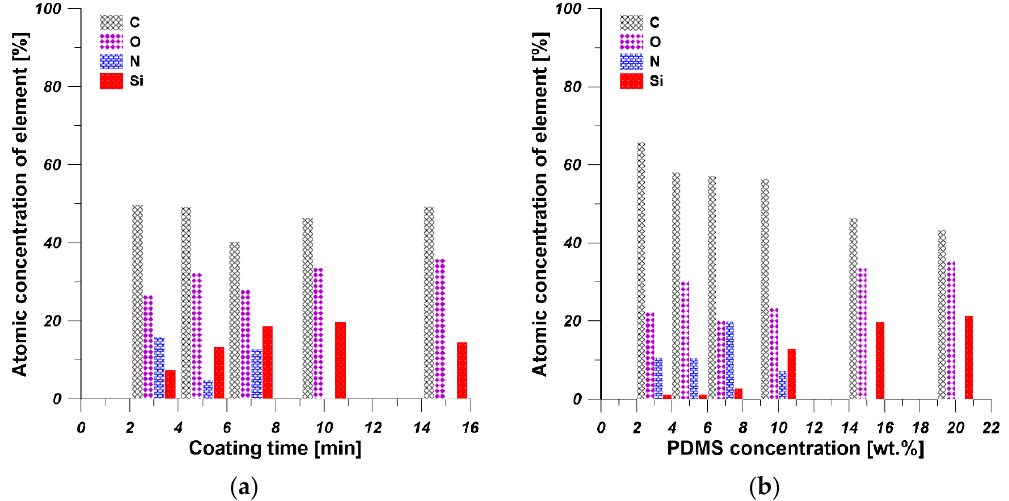
Figure 4. EDX surface mapping results for PDMS/PEI membranes fabricated ( a ) by changing the coating time, using PDMS concentration equal to 15 wt%; ( b ) by using various PDMS concentrations at constant coating time equal to 10 min.